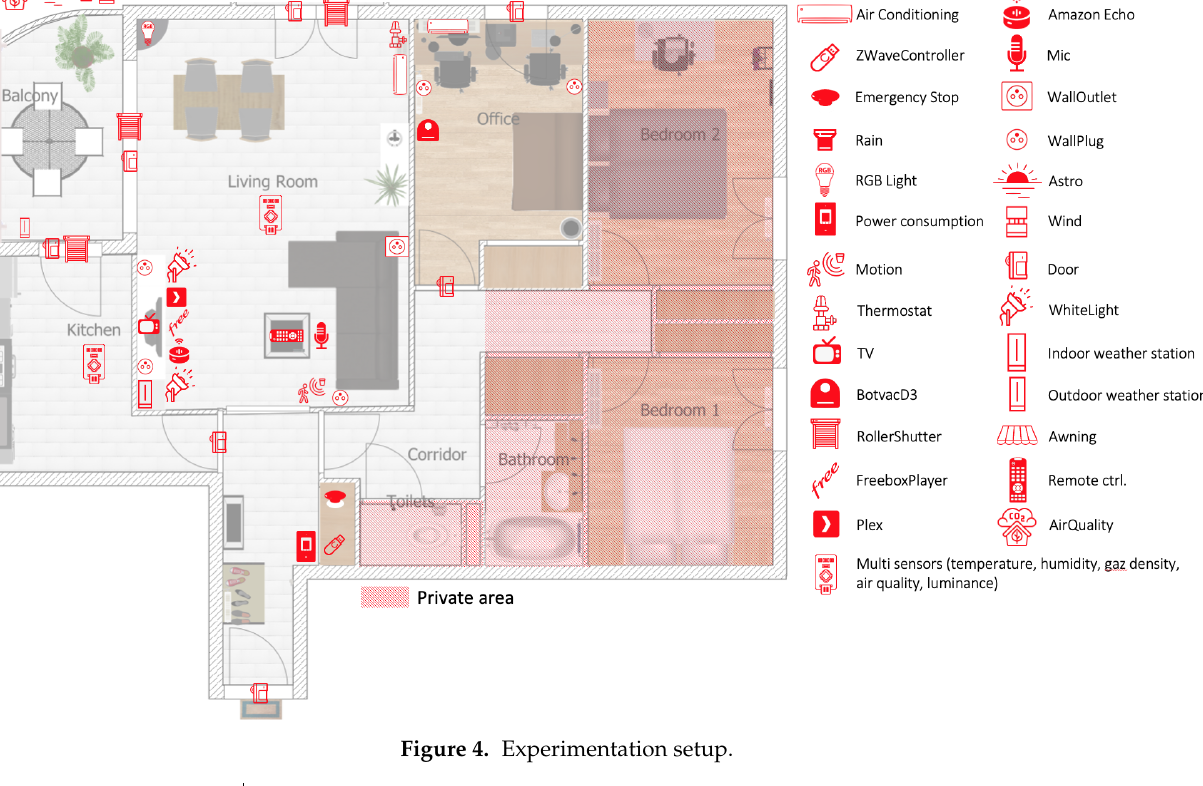
Figure 4. Experimentation setup.